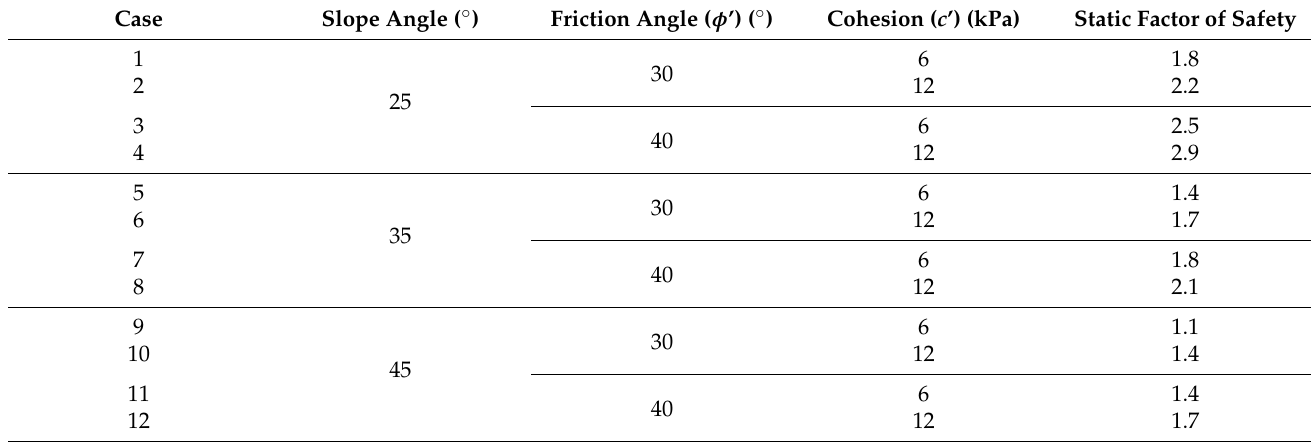
Table 1. Summary of the cases